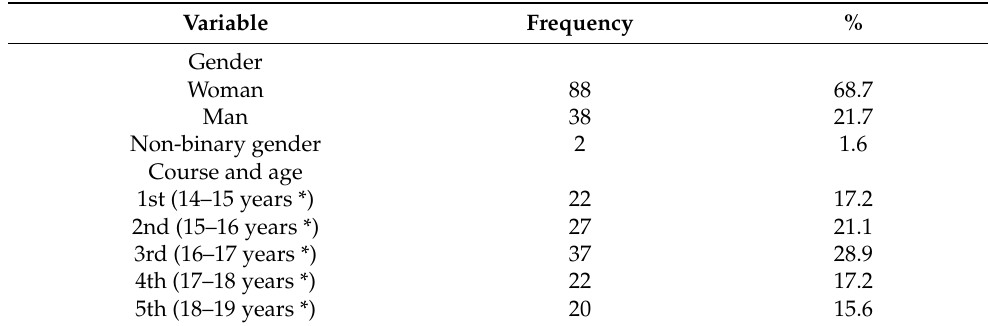
Table 1. Characteristics of the participants (* official student age for each school year). Source: Authors’